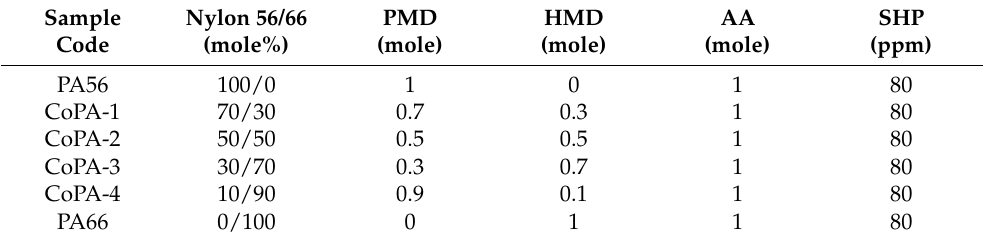
Table 1. Sample code and composition of PA56/66